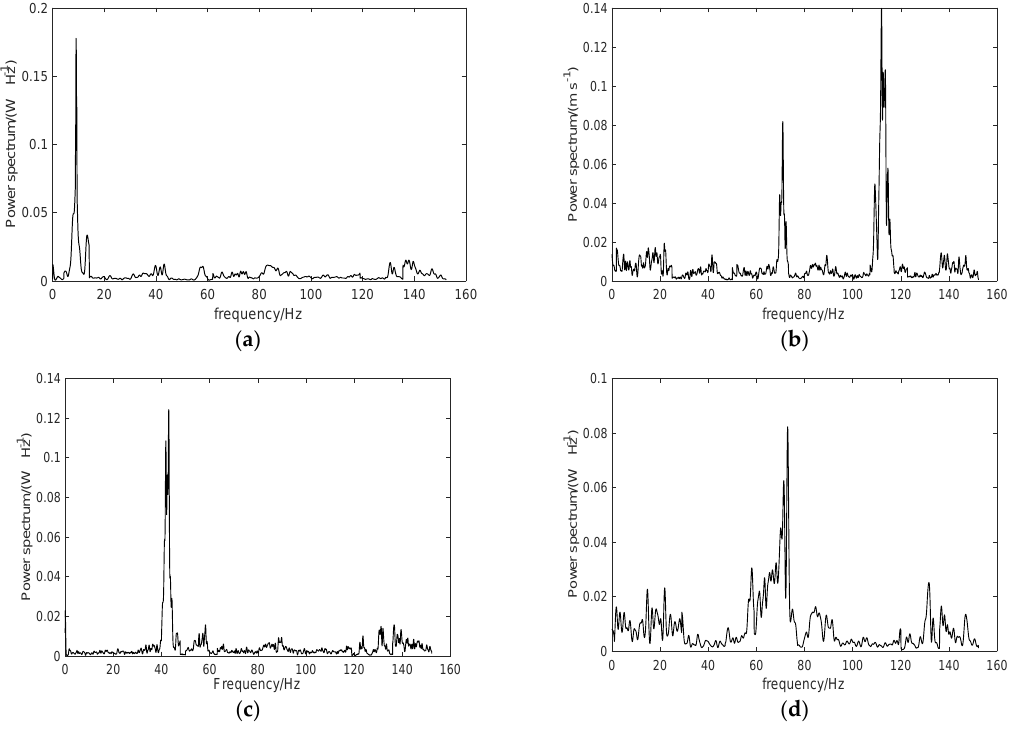
Figure 9. Frequency spectrum of four measuring points before optimization. ( a ) measuring point 1, ( b ) measuring point 2, ( c ) measuring point 3, and ( d ) measuring point 4.